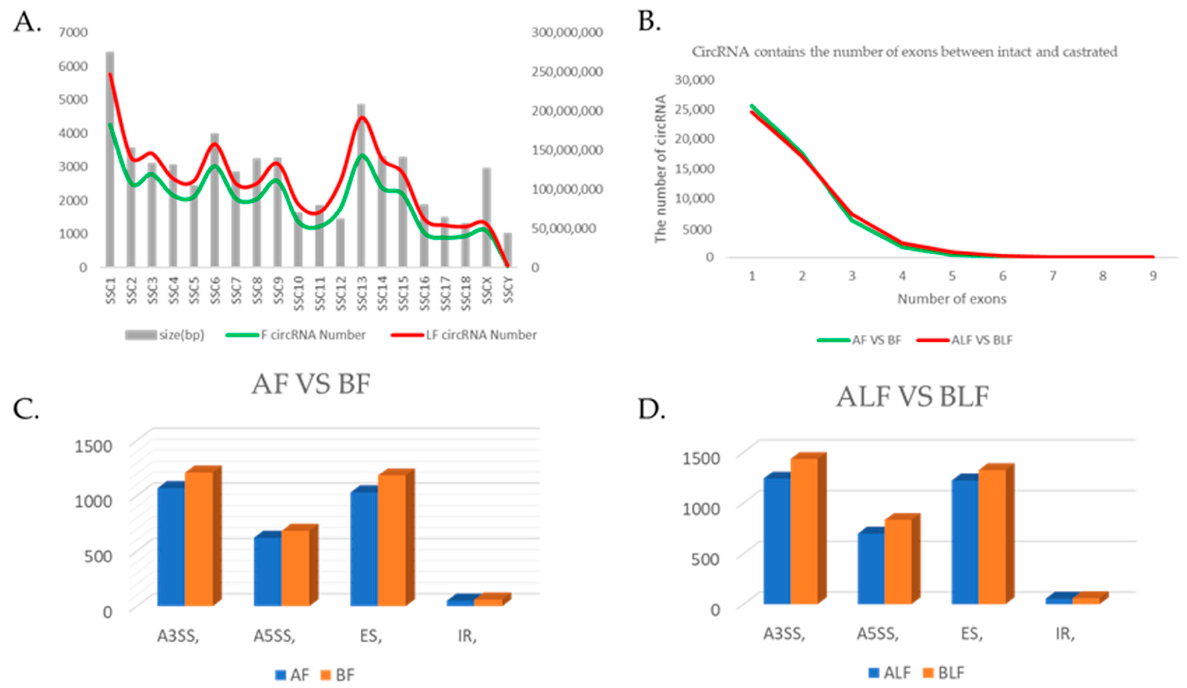
Figure 1. Identification of circRNAs. ( A ) Correlation between the number of circRNAs identified in adipose tissue and the chromosome size (bp). The green line represents the number of circRNAs identified in back adipose tissue, and the red line represents the number of circRNAs identified in abdominal adipose tissue. The Y-axis represents the number of circRNAs identified, and the right axis represents the size of the chromosomes. The X-axis represents the chromosome name. F represents back adipose tissue and LF represents abdominal adipose tissue. ( B ) CircRNA contains the number of exons between the intact and castrated pigs. ( C ) Analysis of the variable splicing forms of circRNAs identified in AF and BF. ( D ) Analysis of the variable splicing forms of circRNAs identified in ALF and BLF. RNA A3SS (3 ′ variable splicing), A5SS (5 ′ variable splicing), IR (intron retention) and ES (exon jumping). AF refers to intact pig backfat tissue, BF refers to castrated pig backfat tissue, ALF refers to intact pig abdominal adipose tissue and BLF refers to castrated pig abdominal adipose